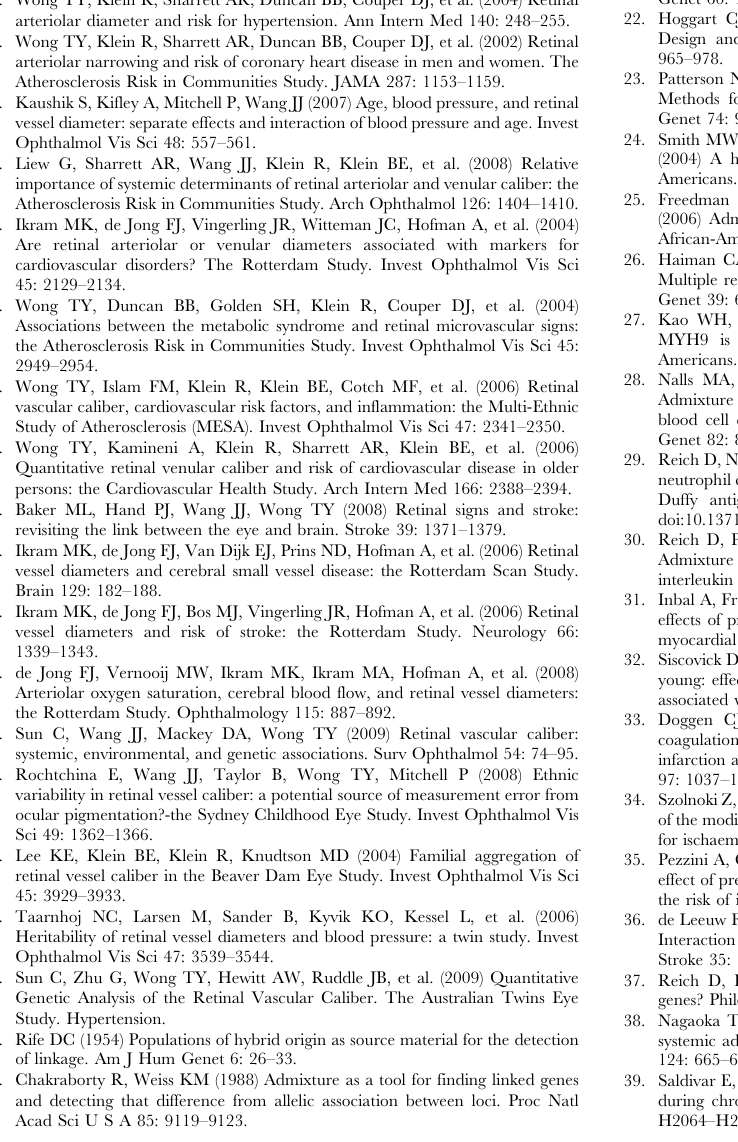
Table S2 Admixture scan results and association of the CRVE to local African ancestry at regions near 6p21.1 in the hypertensive African